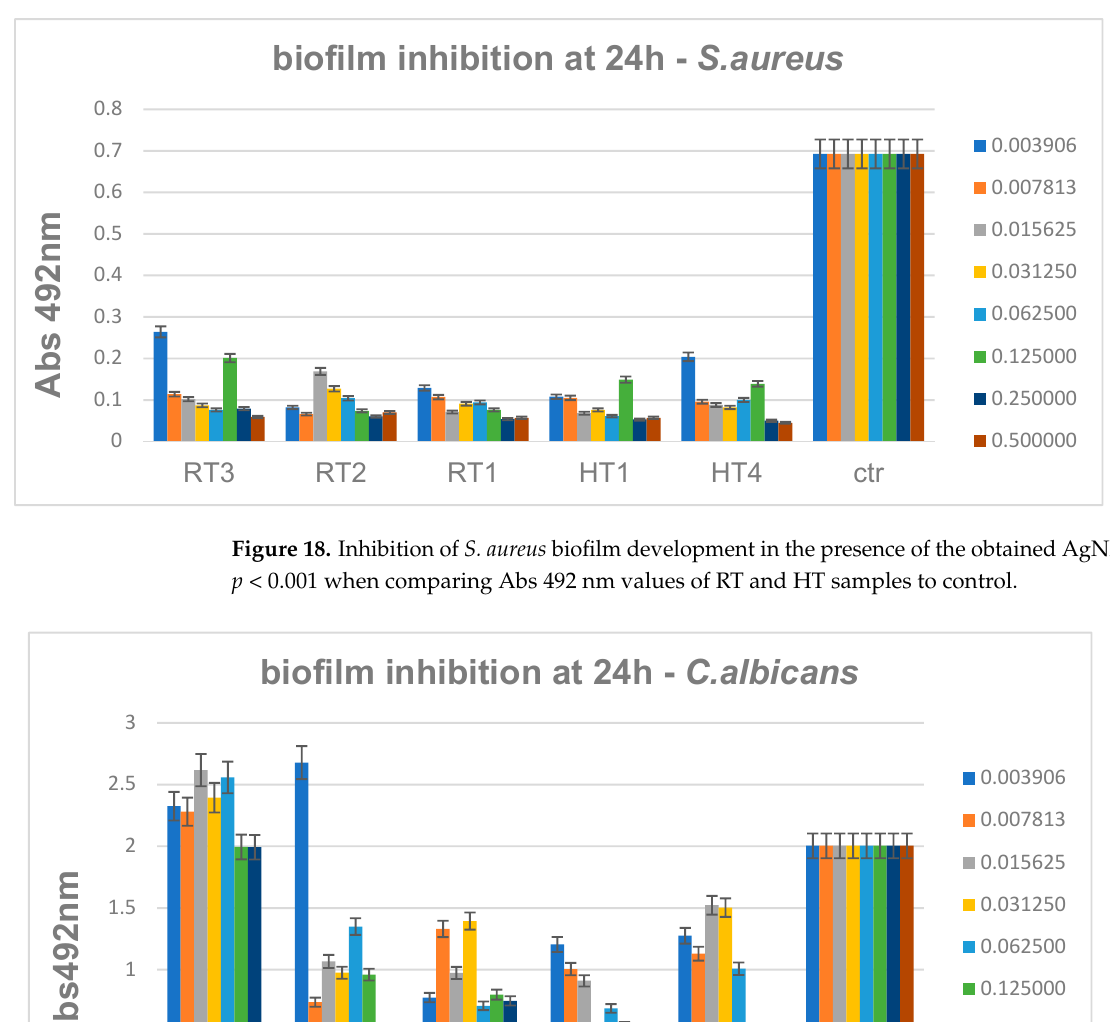
Figure 18. Inhibition of S aureus biofilm development in the presence of the obtained AgNPs for 24 h, p < 0.001 when comparing Abs 492 nm values of RT and HT samples to control .